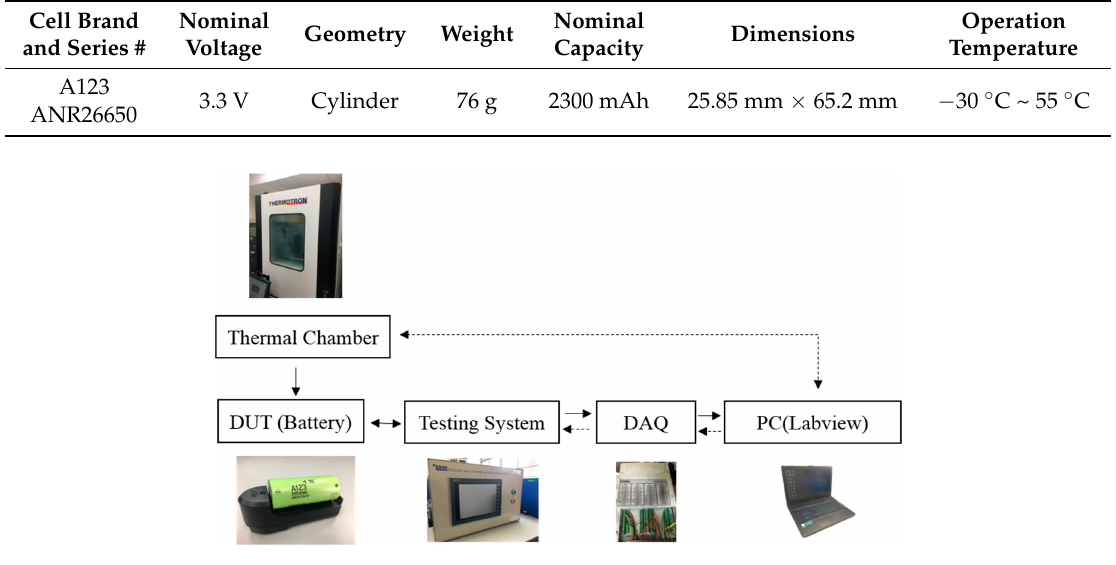
Figure 1. Test system of D 2 SADT.